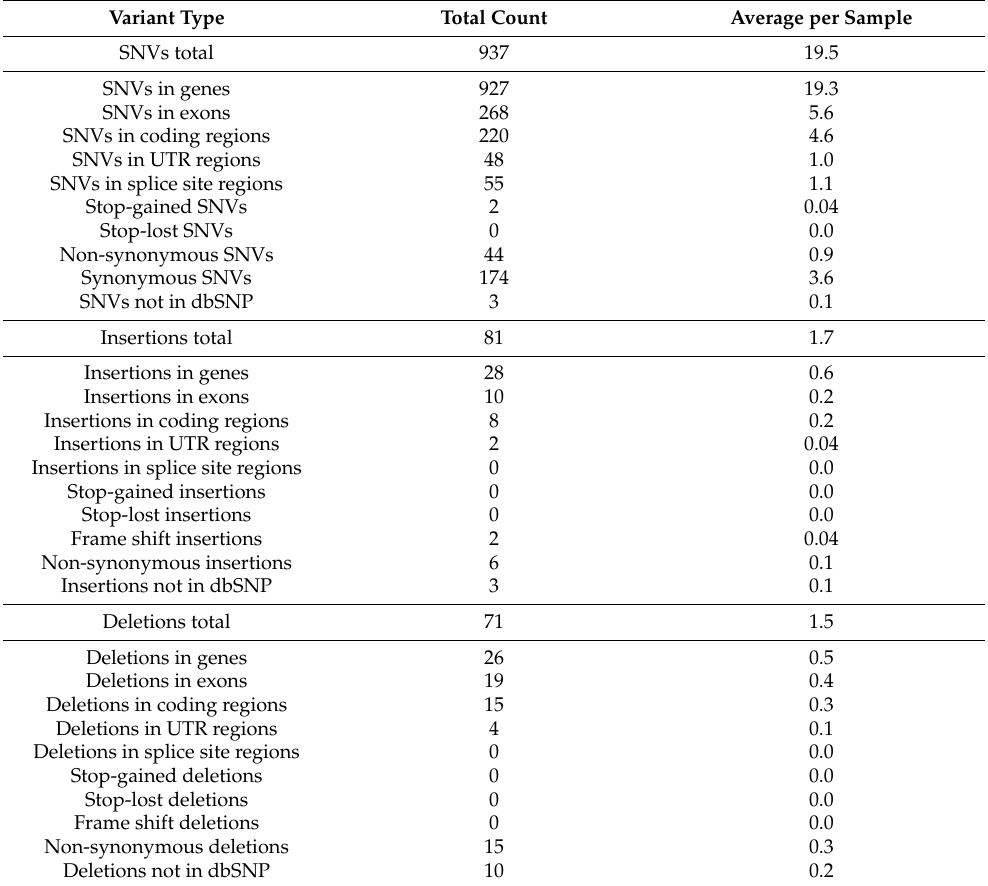
Table 2. Variant types. Variants detected, by type, from the sequencing of 48 pooled sequencing library samples with the 8-gene panel. Metrics for SNVs (single nucleotide variants), insertions, and deletions are shown as total counts and the average count per